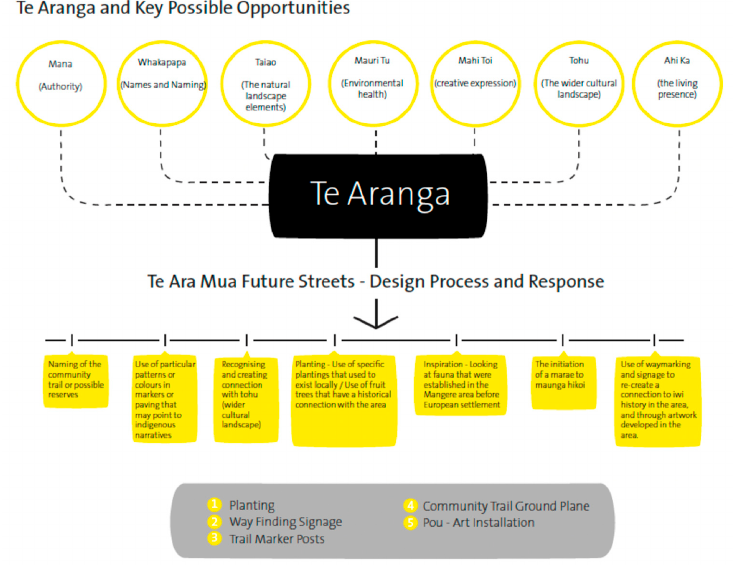
Figure 2. Te Ara Mua—Future Streets: Mana Whenua design plan and outputs.